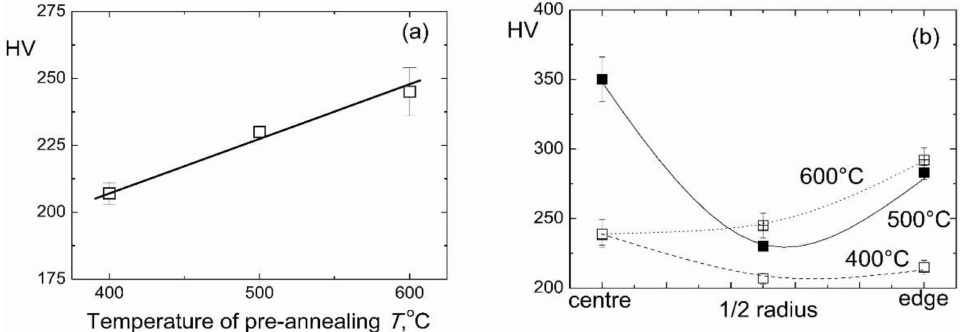
Figure 6. Dependence of microhardness of Ti–4 wt.% Co alloy after HPT on the temperature of preliminary annnealing ( a ) and on the position in the sample ( b